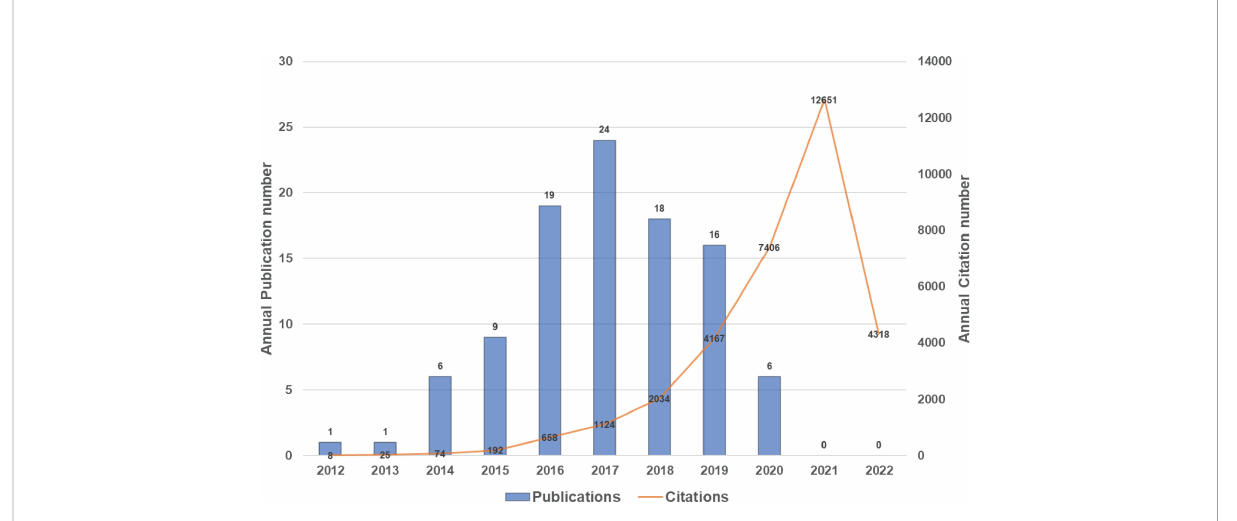
FIGURE 2 Number of top-cited publications from 2012 to